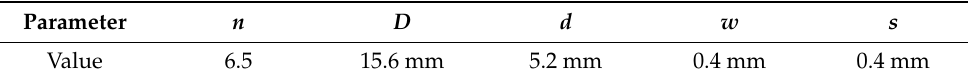
Table 1. Common dimensions of all fabricated planar inductor topologies.